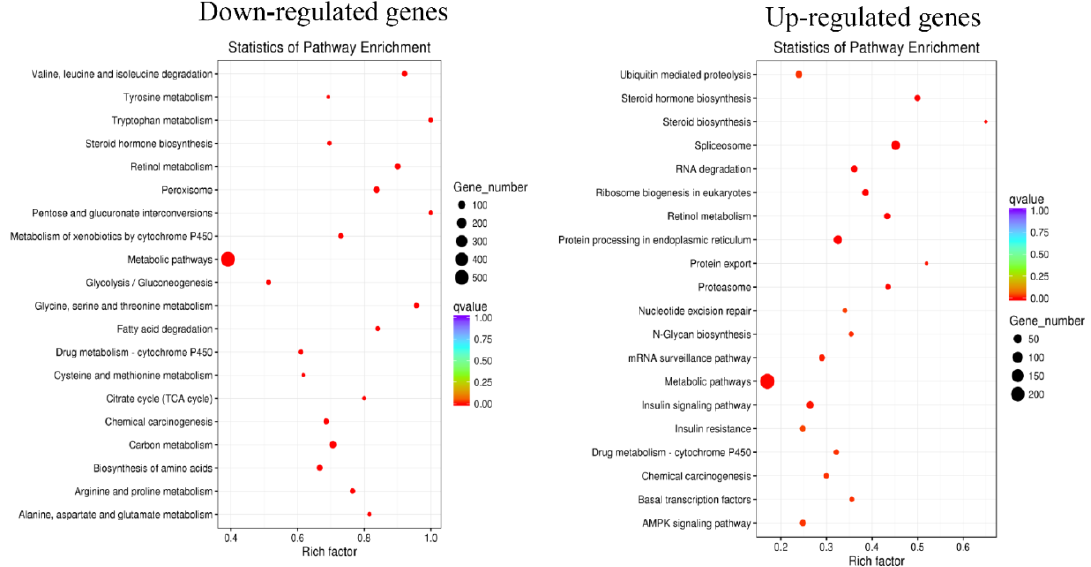
Figure 5. KEGG pathway enrichments of DEGs. The left panel shows 20 enriched KEGG terms for down ‐ regulated DEGs responding to HSAF. The right panel presents up ‐ regulated DEGs. The legend is shown on the picture.